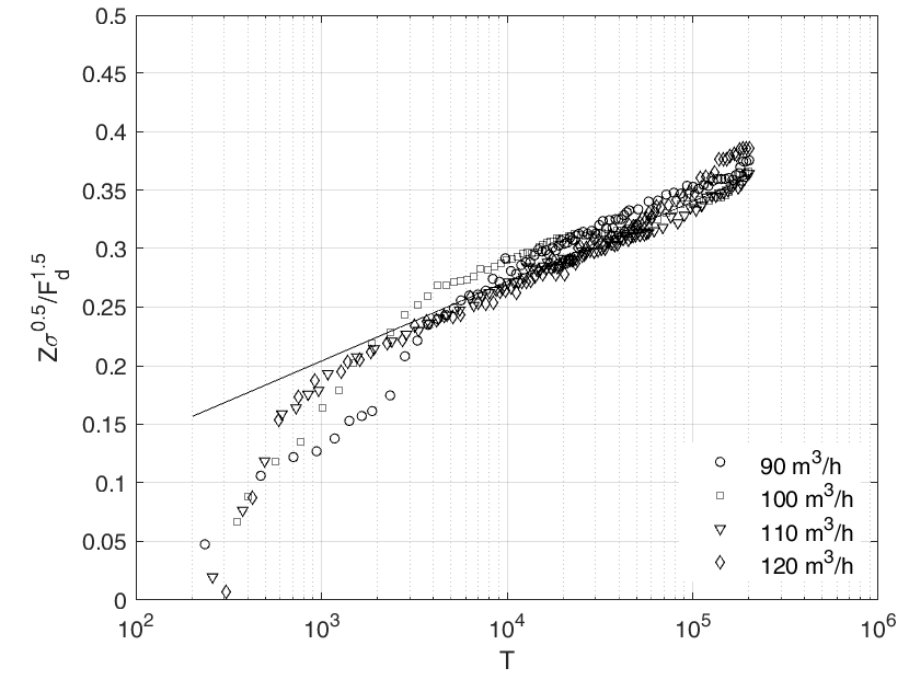
Figure 7. Time evolution of maximum scour depth measurements versus the predictors in the coordinates suggested by Oliveto and Hager [16].